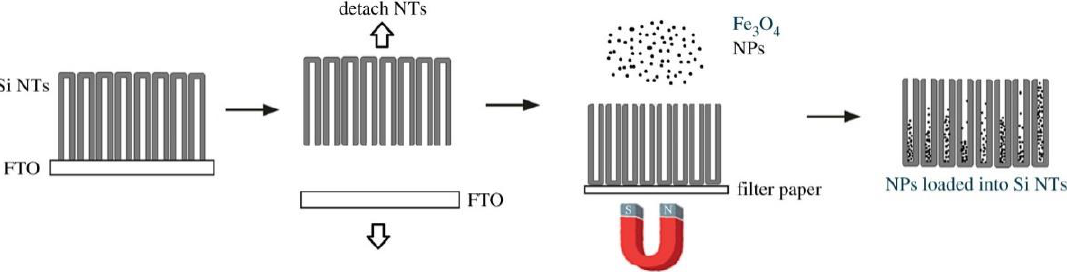
Figure 11. Schematic of MNPs being loaded into SiNTs [153].